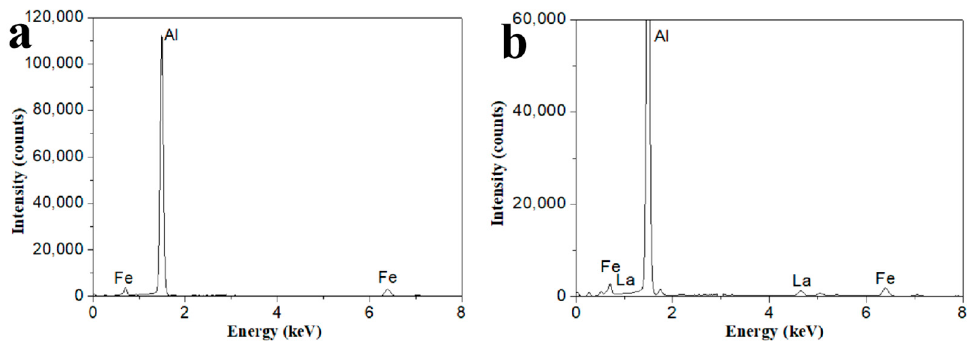
Figure 2. Typical energy dispersive spectroscopy (EDS) analyses of ( a ) phase P; ( b ) phase Q.